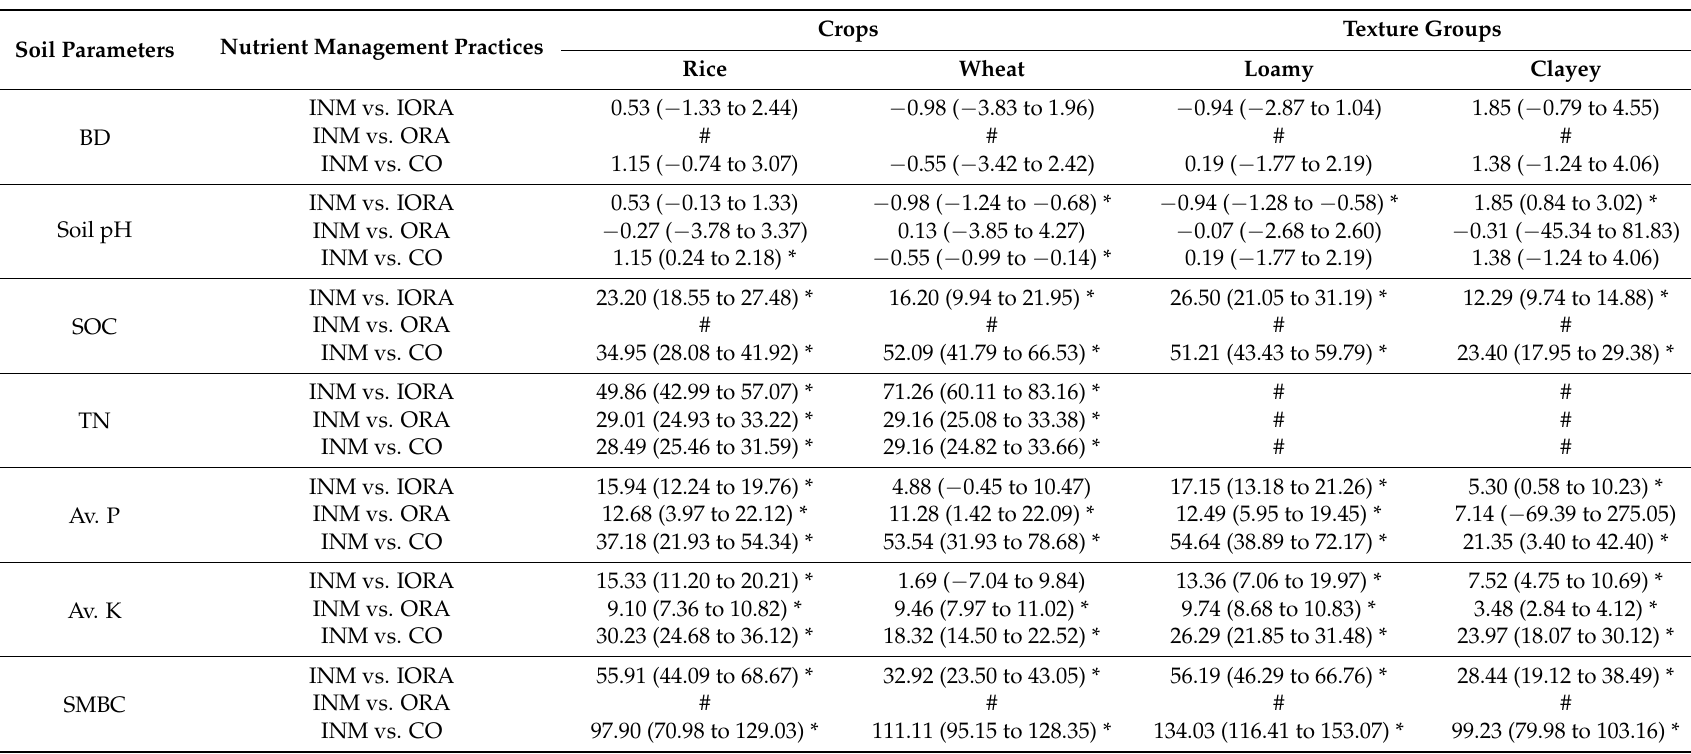
Table 2. Effect of integrated nutrient management on soil properties with respect to inorganic alone, organic alone, and control treatments for rice and wheat crops and as influenced by soil texture (loamy and clayey), in